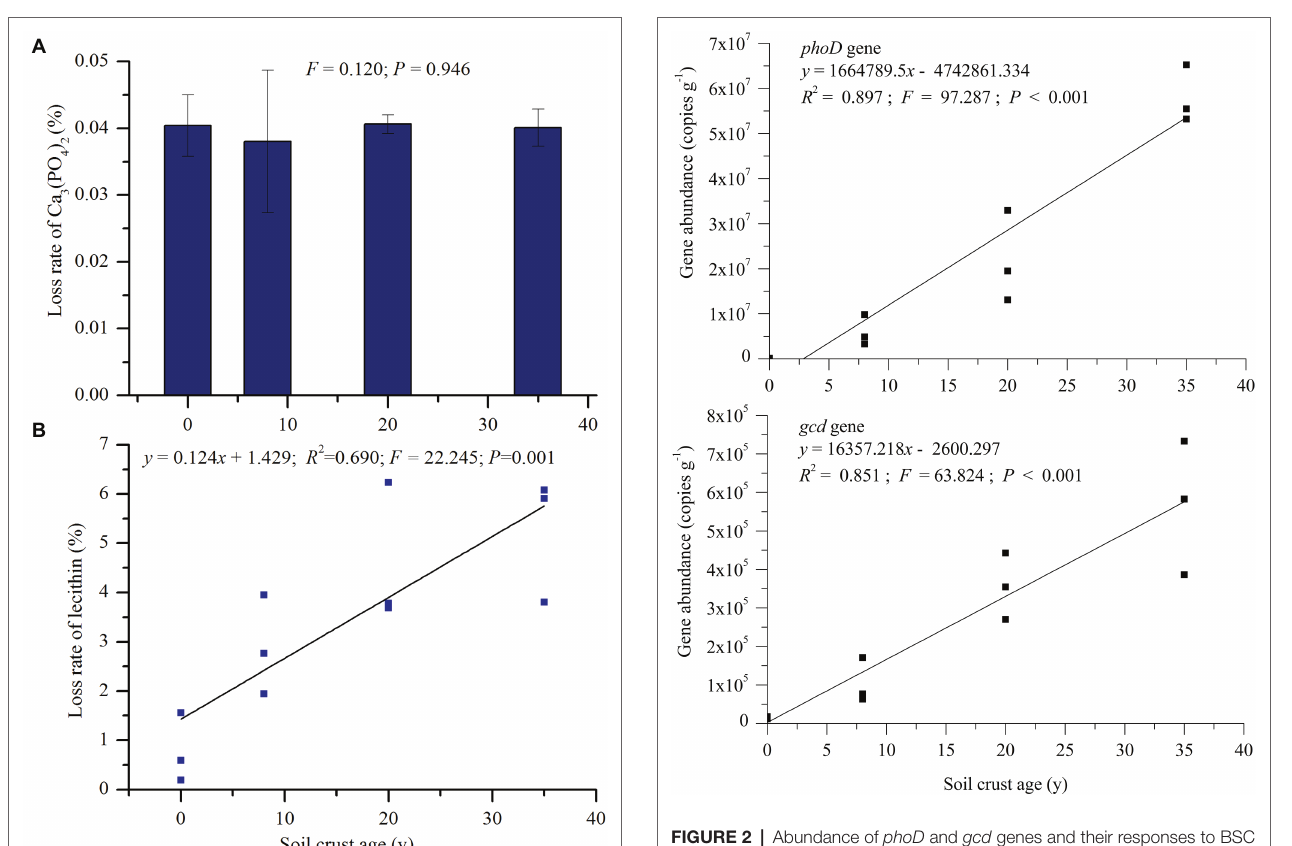
FIGURE 2 | Abundance of phoD and gcd genes and their responses to BSC